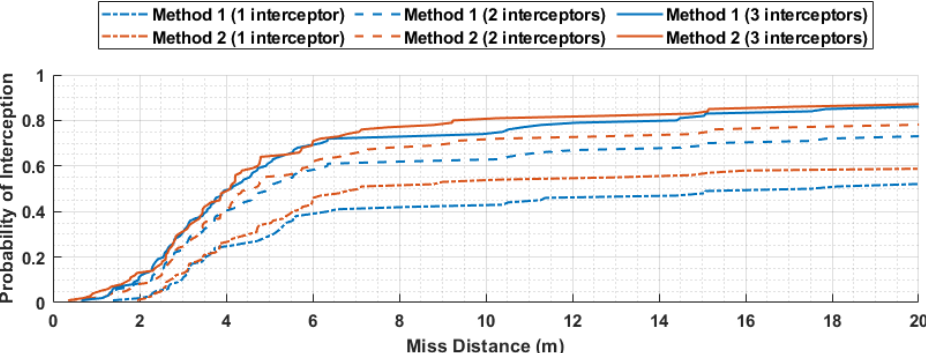
Figure 10. The probability of interception, t α =